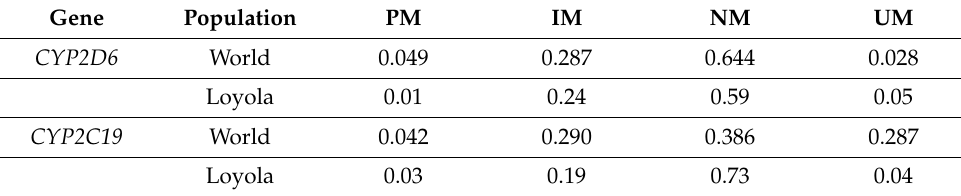
Table 2. Population phenotype frequencies of the world and Loyola sample.